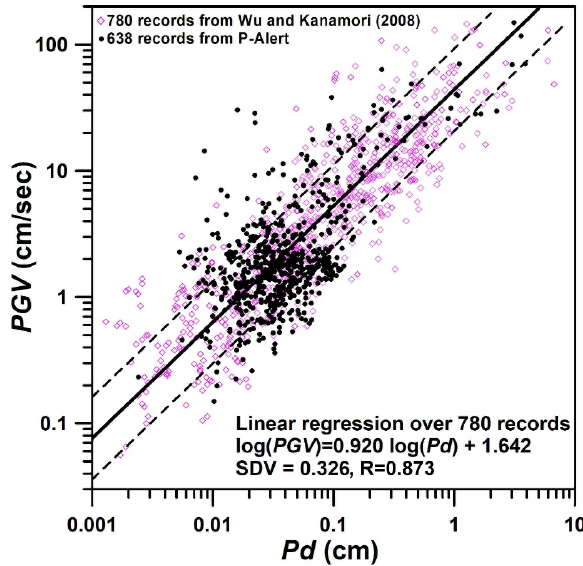
Figure 3. The relationship of P d with PGV by augmenting the 638 P-Alert records obtained during the 5 February 2016 Meinong earthquake and the 6 February 2018 Hualien earthquake with 780 records from Taiwan, Japan, and California via the strong motion instrument used by Wu and Kanamori (2008)